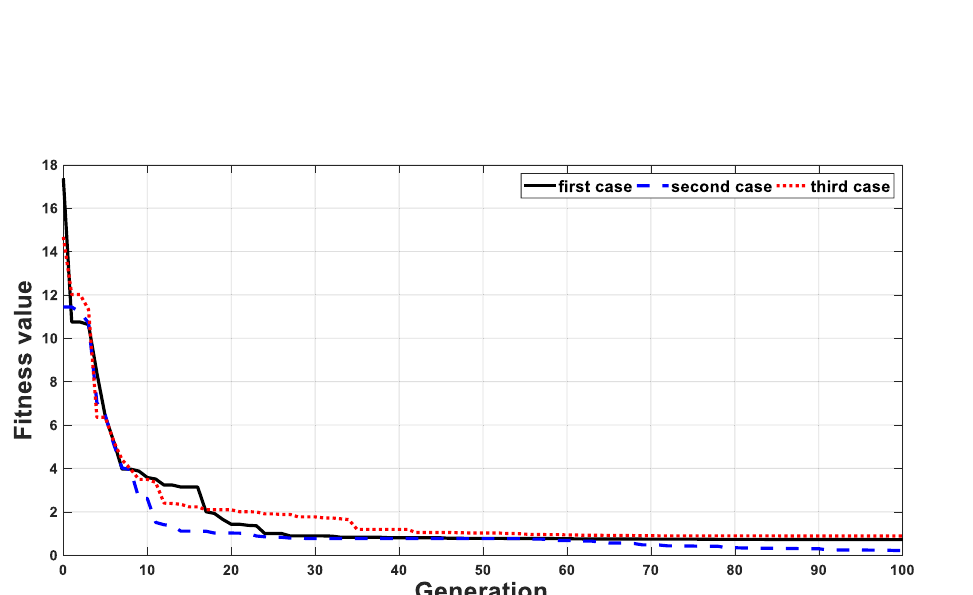
Figure 4. Convergence of objective function using